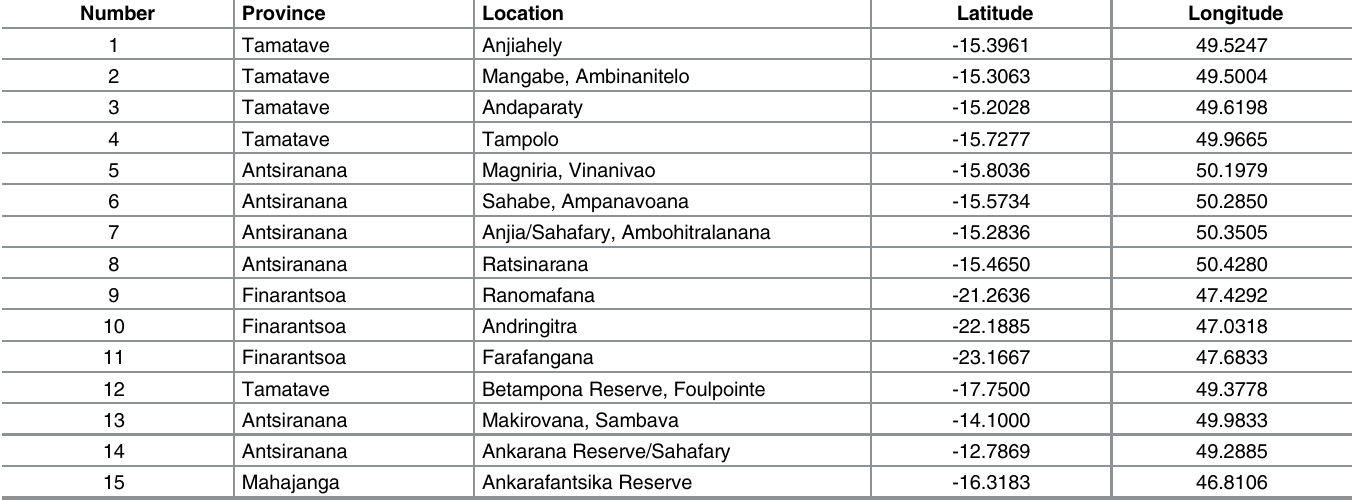
Table 1. Geographic positions of sampling sites in Madagascar. Site numbers are as in Fig 1. The coordinates are averaged over all samples collected at a given